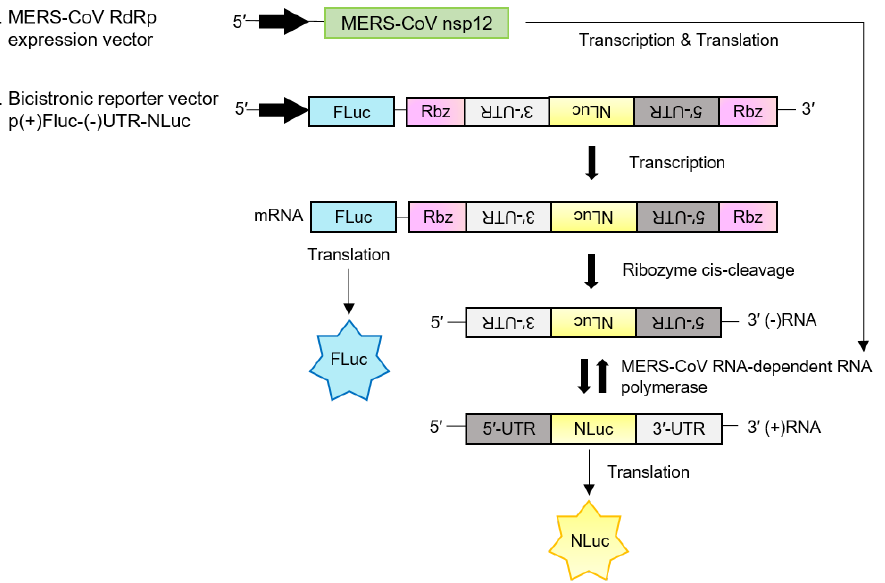
Figure 1. Schematic diagram of the cell-based reporter assay system for Middle East respiratory syndrome coronavirus (MERS-CoV) RNA-dependent RNA polymerase (RdRp) activity. This system is composed of the human codon-optimized FLAG-tagged MERS-CoV nsp12 plasmid construct for MERS-CoV RdRp expression and the bicistronic reporter construct p(+)FLuc- (− )UTR-NLuc, which contains the firefly luciferase gene in the sense orientation, (+)FLuc and the Nano-glo ® luciferase gene in the antisense orientation, (−)NLuc, which is flanked by the antisense 5′ -untranslated region (UTR) and 3′ -UTR of MERS-CoV and the hepatitis delta virus (HDV) ribozyme self-cleavage sequence. The full-length p(+)FLuc- (−)UTR -NLuc RNA transcripts are processed by the HDV ribozyme via self- cleavage, and the exposed (−)NLuc flanked by the antisense 5′ - and 3′ -UTR RNA can be replicated by MERS-CoV RdRp. Then, the replicated (+)NLuc RNA is translated, and the expression level of NLuc